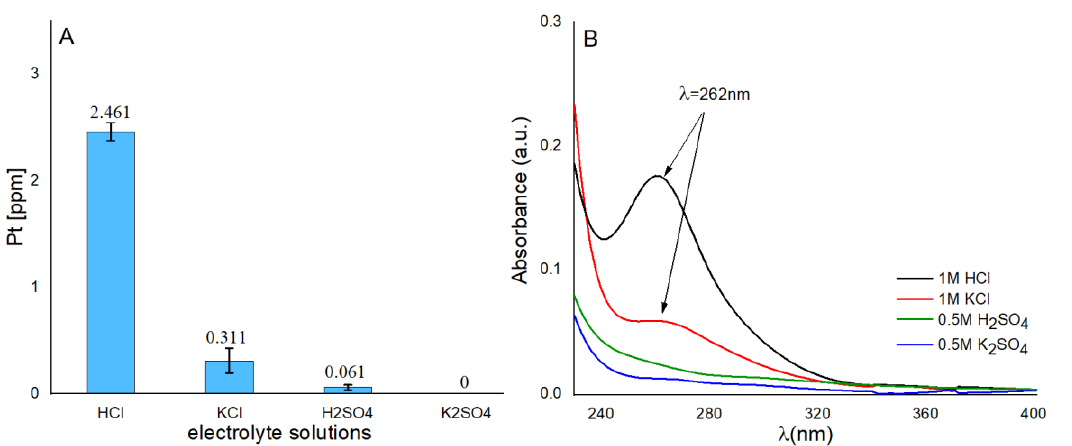
Figure 2. ( A ) Amount of dissolved Pt during 24 h for each electrolyte solution; ( B ) UV/vis absorbance spectra of the electrolytes recorded after the dissolution of the platinum disk electrode.